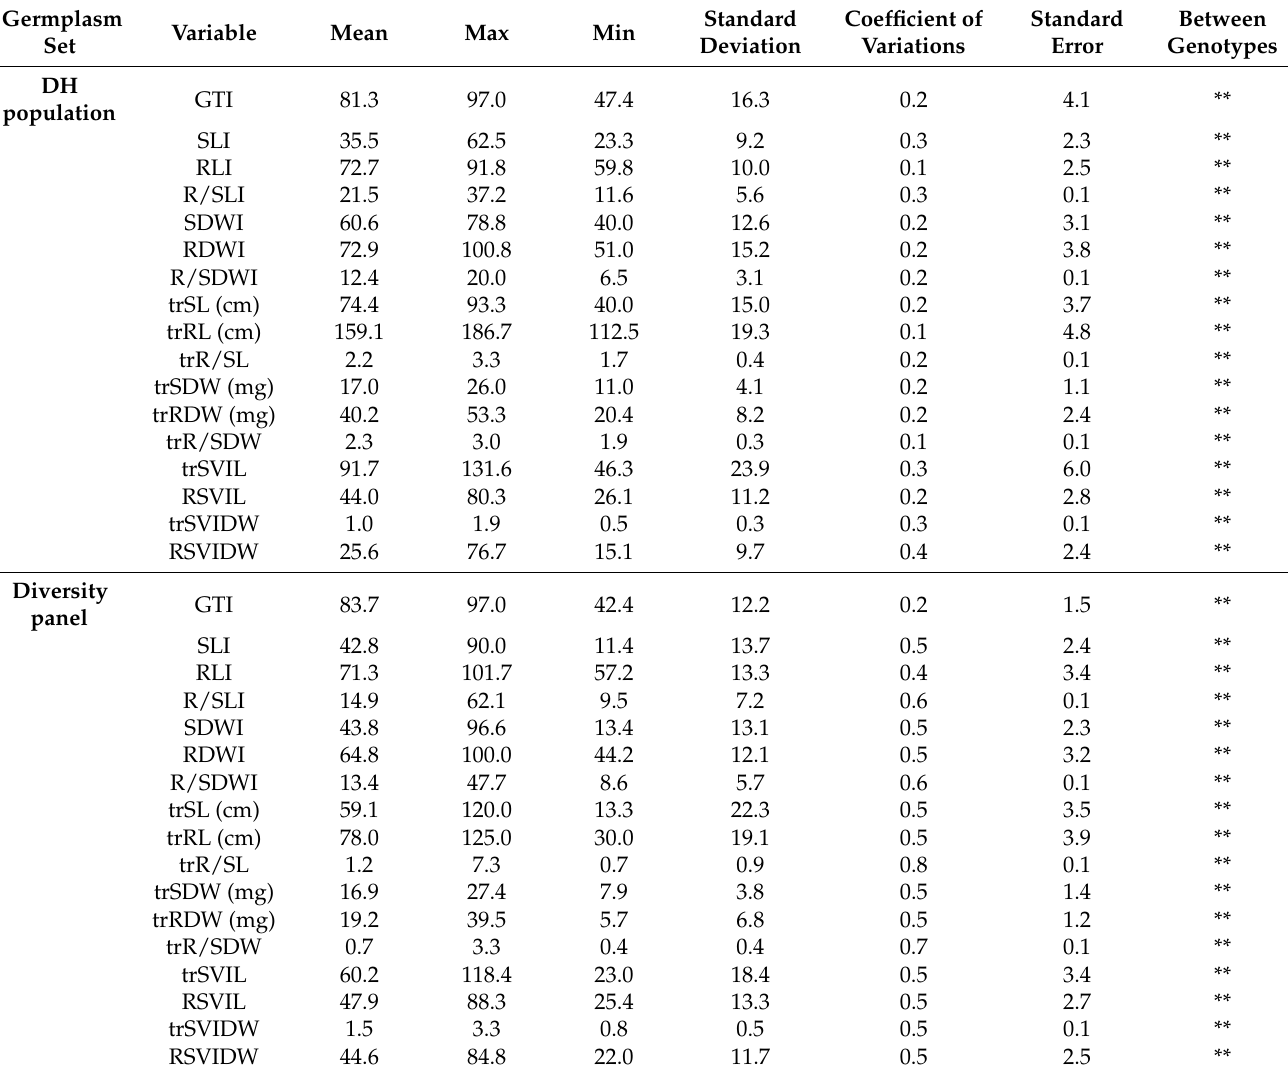
in both CM72/Gairdner DH population and barley germplasm diversity panel (Table 1). The average GTI was highest for both DH population and diversity panel at 81.3% and 83.7%, while R/SDWI was the lowest at 12.4% and 13.4%, respectively. BmnL-75 had the highest RSVI for both length (84.5%) and weight (79.9%) but with a GTI of 88.9% among the diversity panel germplasm set (Figure 3). Interestingly, C01P-53 recorded the lowest level of indices in GTI (42.4%), RSVIL (25.5%) and 21.6% for RSVIDW (Figure 3 and Table S3). Table 1. Seedling survival extent of variations in barley germplasms in response to 150 mM NaCl salinity stress. Germplasm